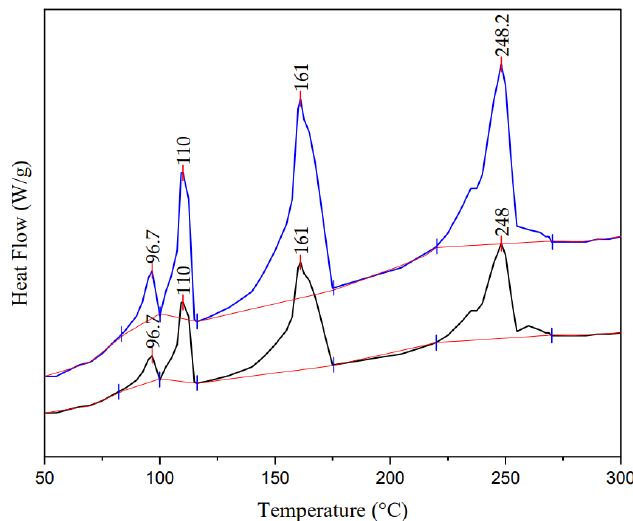
Figure 5. Sample thermogram with MPs mixture. Table 2. Identification of the MPs in the different neighborhoods.